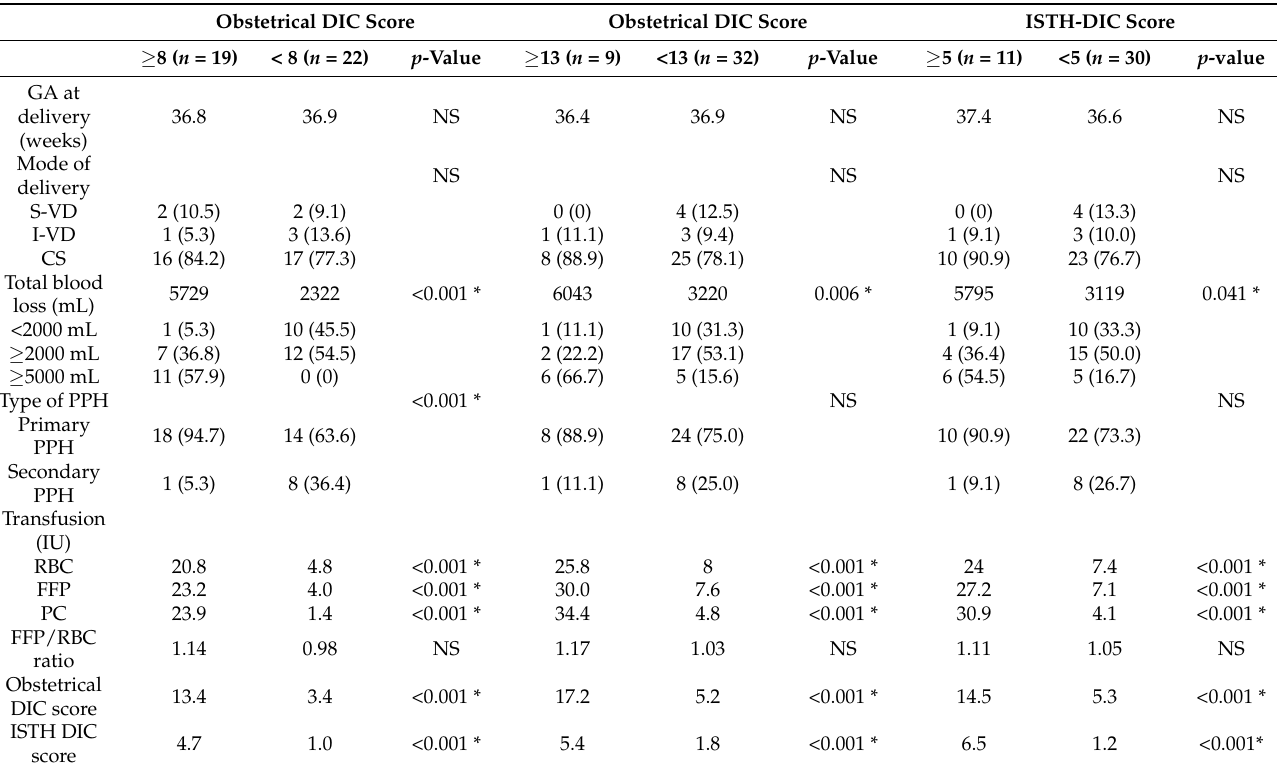
Table 4. Comparison of the obstetric outcomes in patients with or without